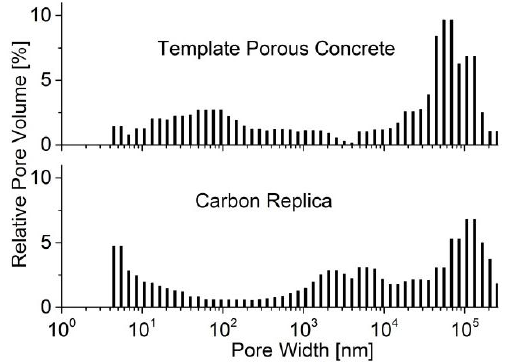
Figure 3. Pore size distribution (obtained by mercury intrusion) of the porous concrete-made template and the according carbon replica (carbonized at 873 K).